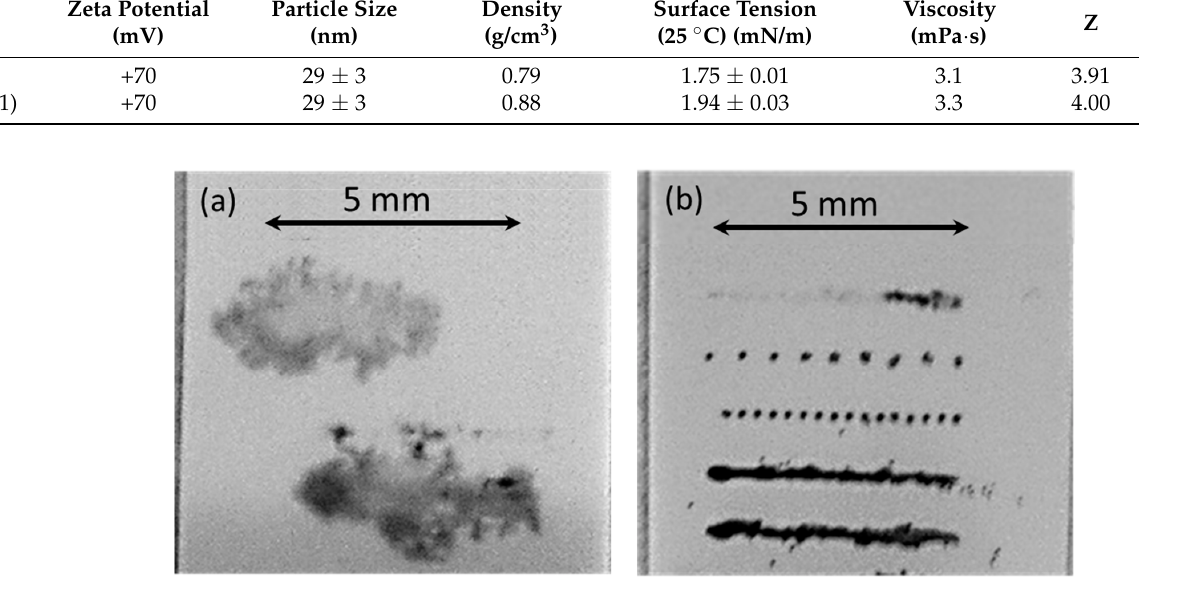
Figure 2. Printed lines of the ( a ) TiN isopropanol and ( b ) TiN 3:1 isopropanol:DEG